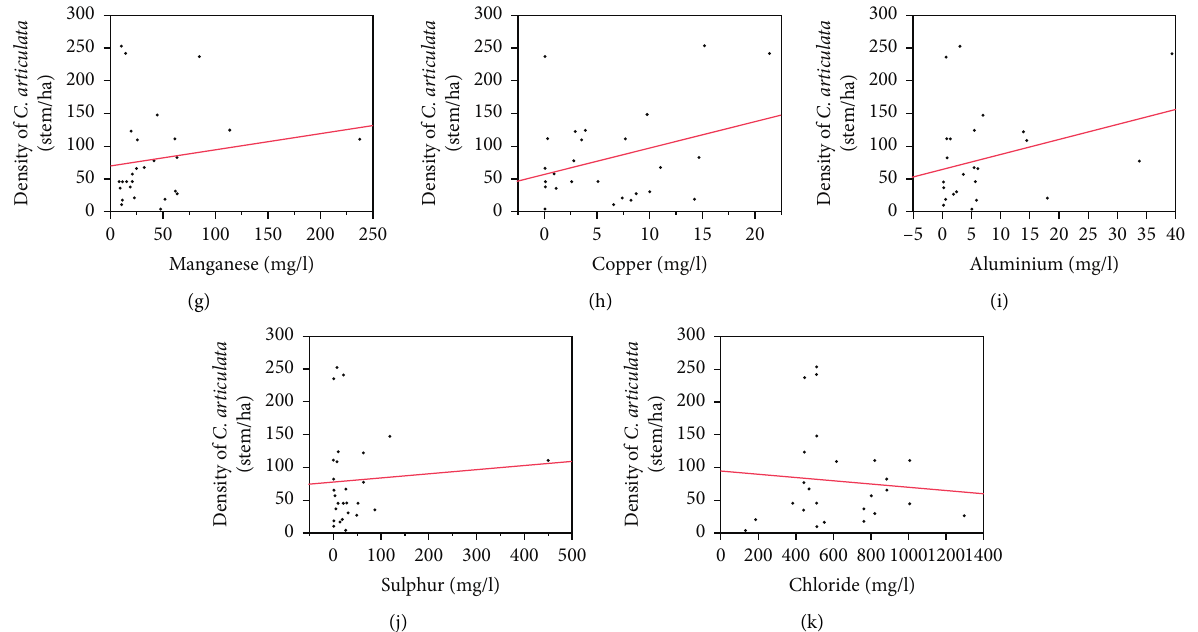
Figure 8: (a–k) Relationships between soil chemical parameters and density of C. articulata . Scatter plots with ∗ showed significant associations between density of C. articulata and the soil chemical parameter at ( p < 0 . 05) based on the Pearson product-moment correlation